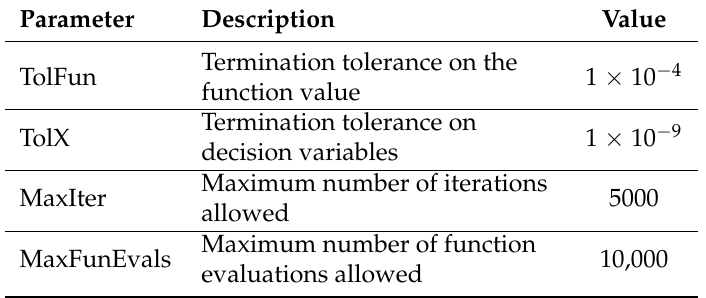
Table 4. Non-default values of optimization options used in fmincon routine in DR runs.